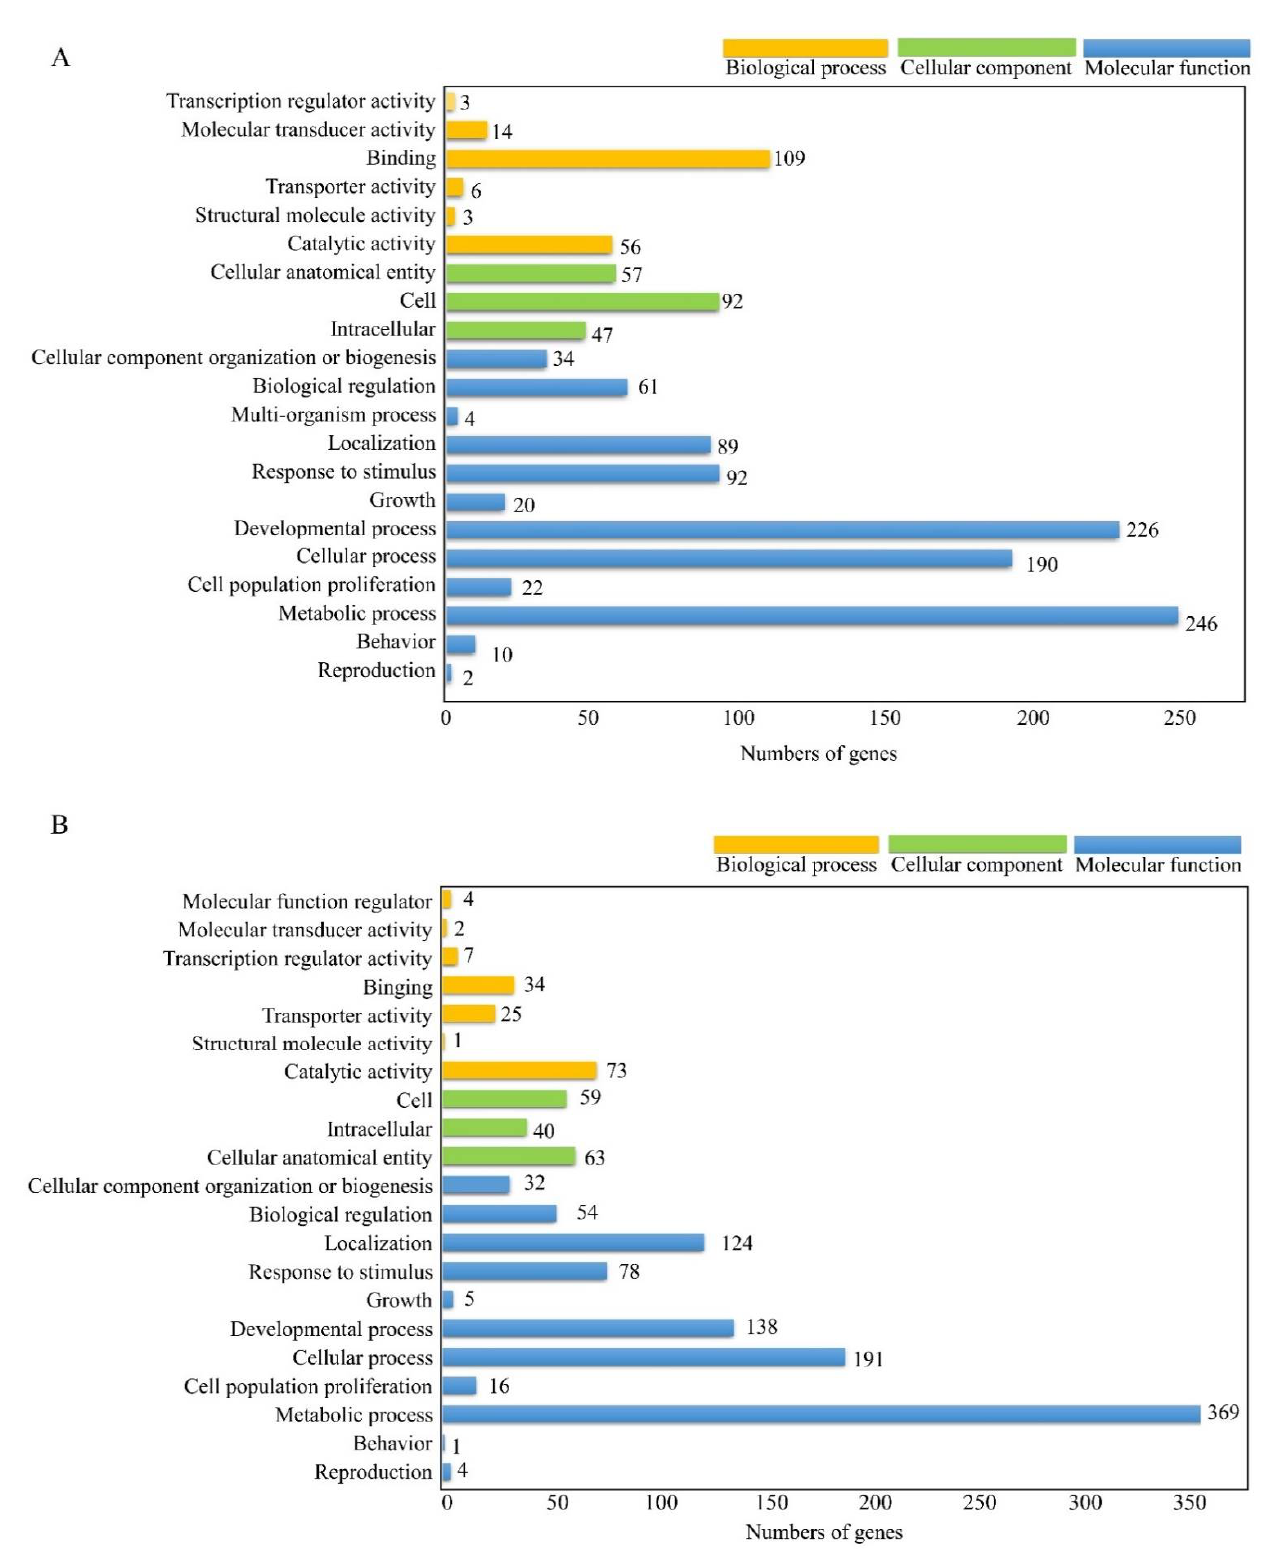
Figure 2. Functional distribution of GO annotation extracted from chlorophyllides composites treatments. ( A ) MCF-7 cells with chlorophyllides composites treatments. ( B ) MDA-MB-231 cells with chlorophyllides composites treatments. The results of GO enrichment analysis of DEGs were classified into three categories: molecular functions, cellular component and biological process. The y -axis is gene functional classification of GO, while x -axis is the corresponding number of genes.